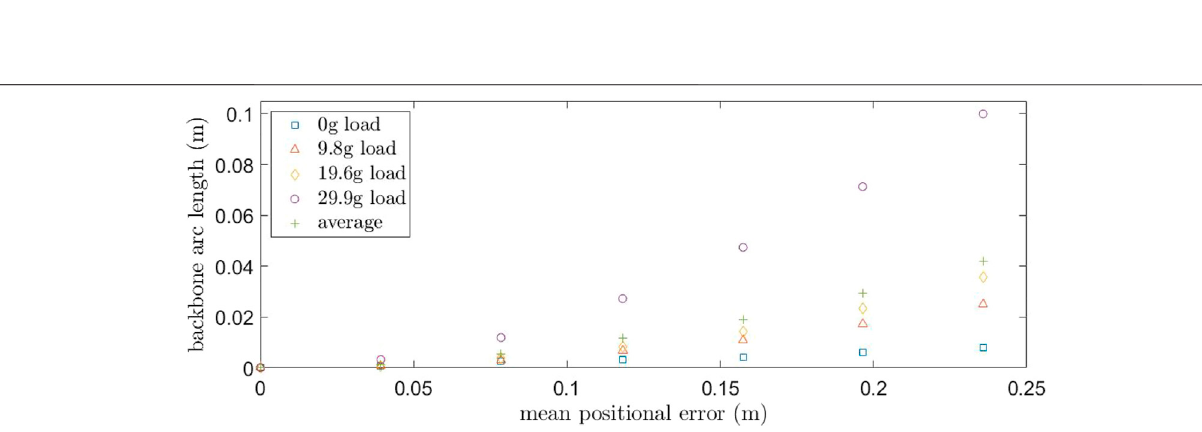
FIGURE11| Predictedand realizedbackbonepositionforthe (A) 0 N, (B) 96.14N, and (C) 189.92 N tipload. Thetable summarizesthe tensioncombinations for the different points. Red lines indicate model prediction and circles indicate the OptiTrack observations.